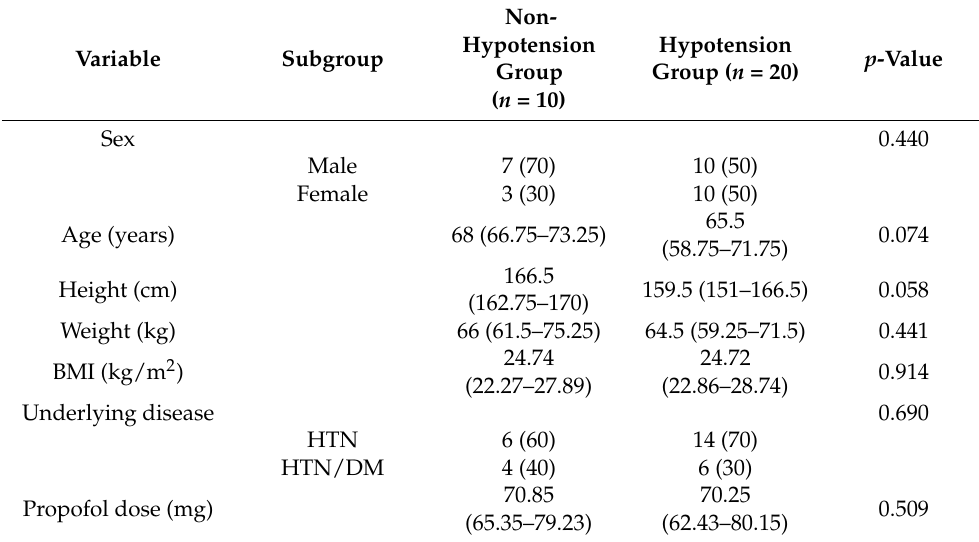
Table 1. Demographic data and baseline characteristics ( n = 30).